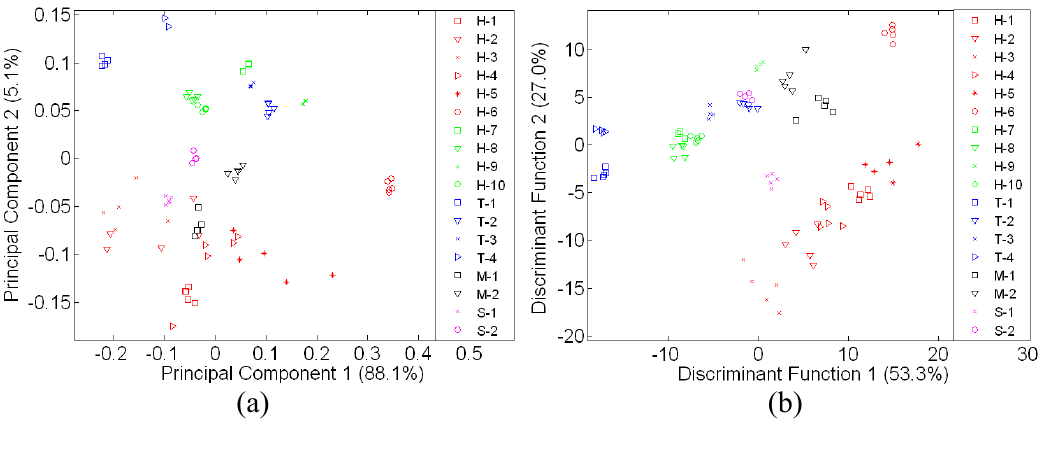
Figure 8. A global map of e-tongue assessment on of 18 different honey, sugar and adulterated sample ( a ) Using PCA and ( b ) Using